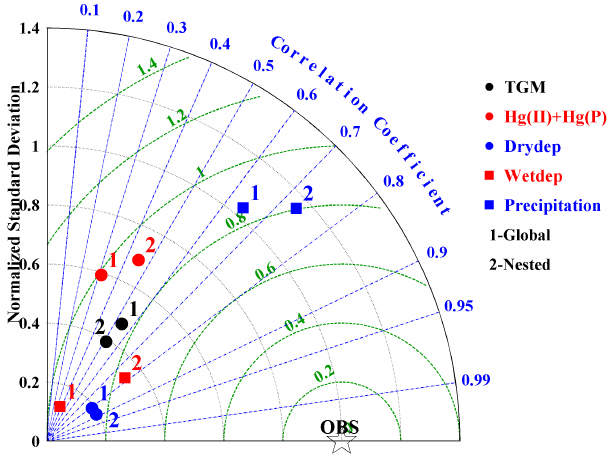
Figure 12. Contributions of Chinese primary anthropogenic sources to (a) annual mercury surface concentrations (ngm − 3 ) and (b) to- tal (wet plus dry) deposition (µgm − 2 yr − 1 ) in the Northern Hemi-